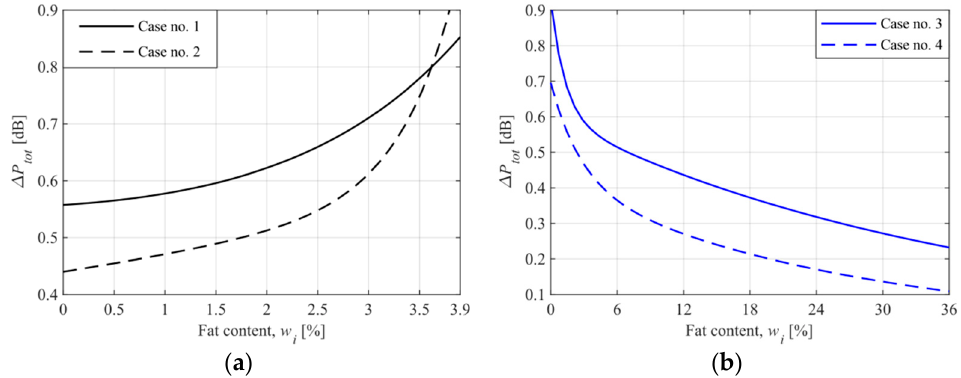
Figure 10. The total error of power measurement based on the standard deviation of power readings during calibration of the system (( a )—cases no. 1 and 2, for the operating point at 3.9%, ( b )—cases no. 3 and 4, for the operating point at 0%).